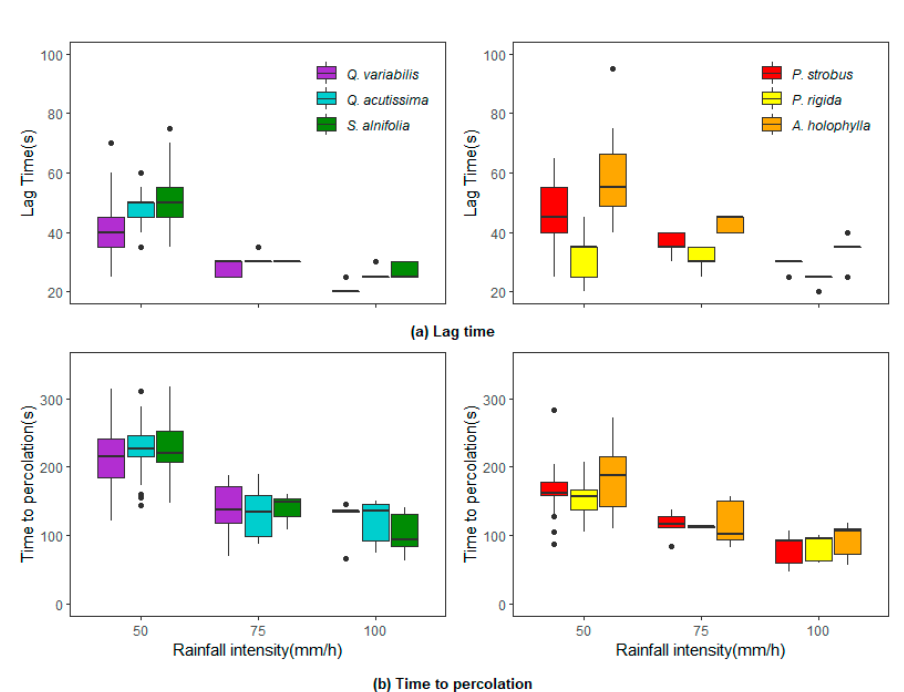
Figure 7. Variation in lag time and time to percolation with litter type and rainfall intensity. ( a ) Lag time, ( b ) Time to percolation.